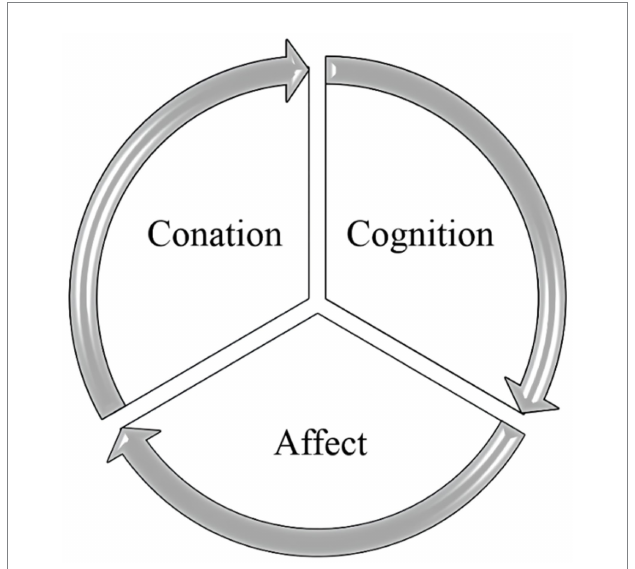
FIGURE 1 Cognition-affect-conation pattern (CAC)